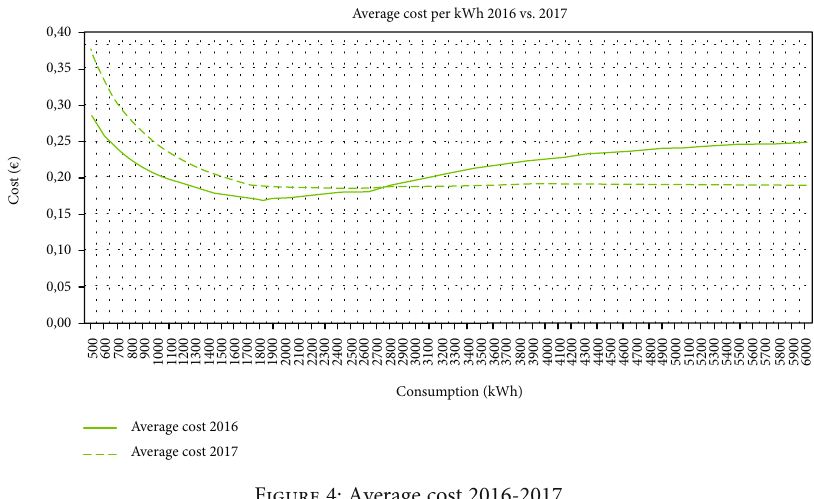
Figure 4: Average cost 2016-2017. Table 11: Energy bills 2016 vs. 2017 and average